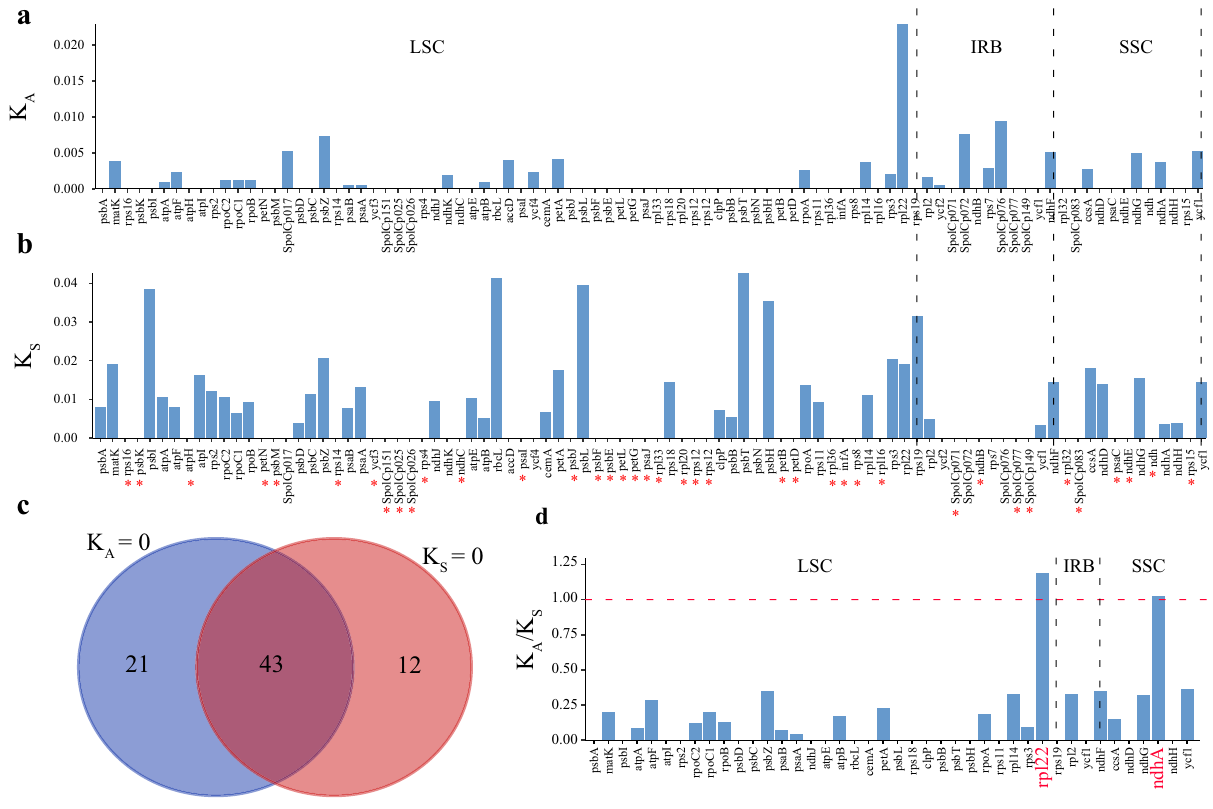
Figure 6. Non-synonymous (K A ), synonymous (K S ), and K A /K S substitution values of S. tetrandra . ( a ) K A , ( b ) K S , and ( d ) K A /K S substitution values. ( c ) Venn diagram of protein-coding genes with K A = 0 and K S = 0. The genes highlighted in red were under positive selection during the Spinacia